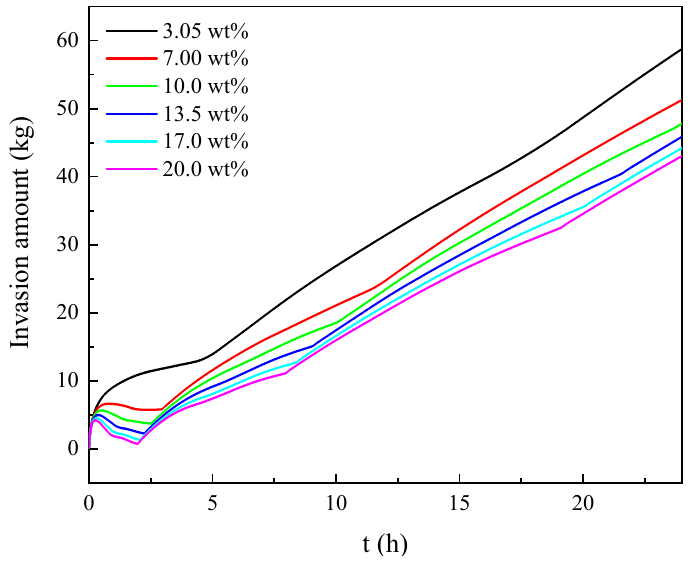
Figure 16. Variation in drilling fluid invasion amount with time within 24 h during the drilling fluid invasion process under various drilling fluid salinity values. invasion process under various drilling fluid salinity